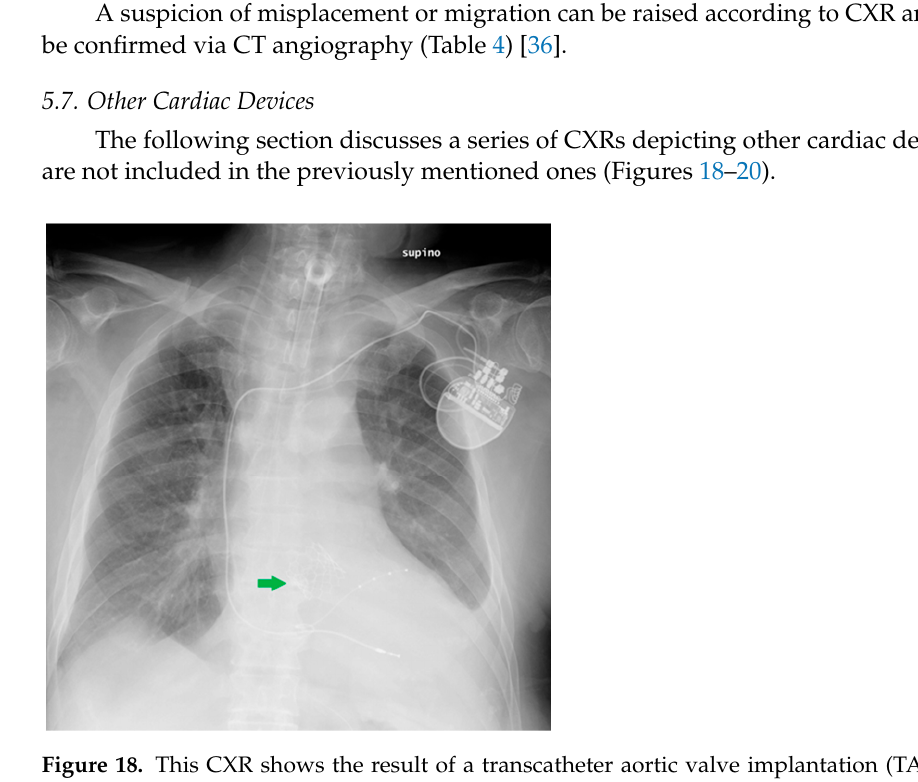
Figure 19. Coronary artery stents (red arrows), barely visible on the PA projection ( a ), can be better appreciated on the LL view ( b ).